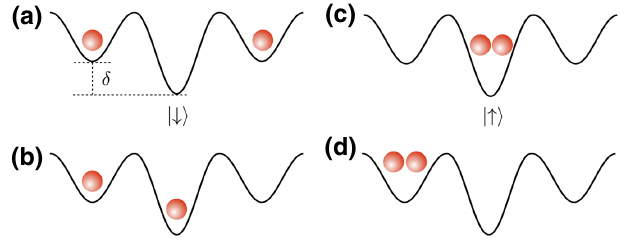
FIG. 1. A schematic of the different states of a three-site build- ing block. When U ≈ 2 δ and J → 0, the energies of (a) and (b) are nearly degenerate and are off resonance with the energies of (c) and